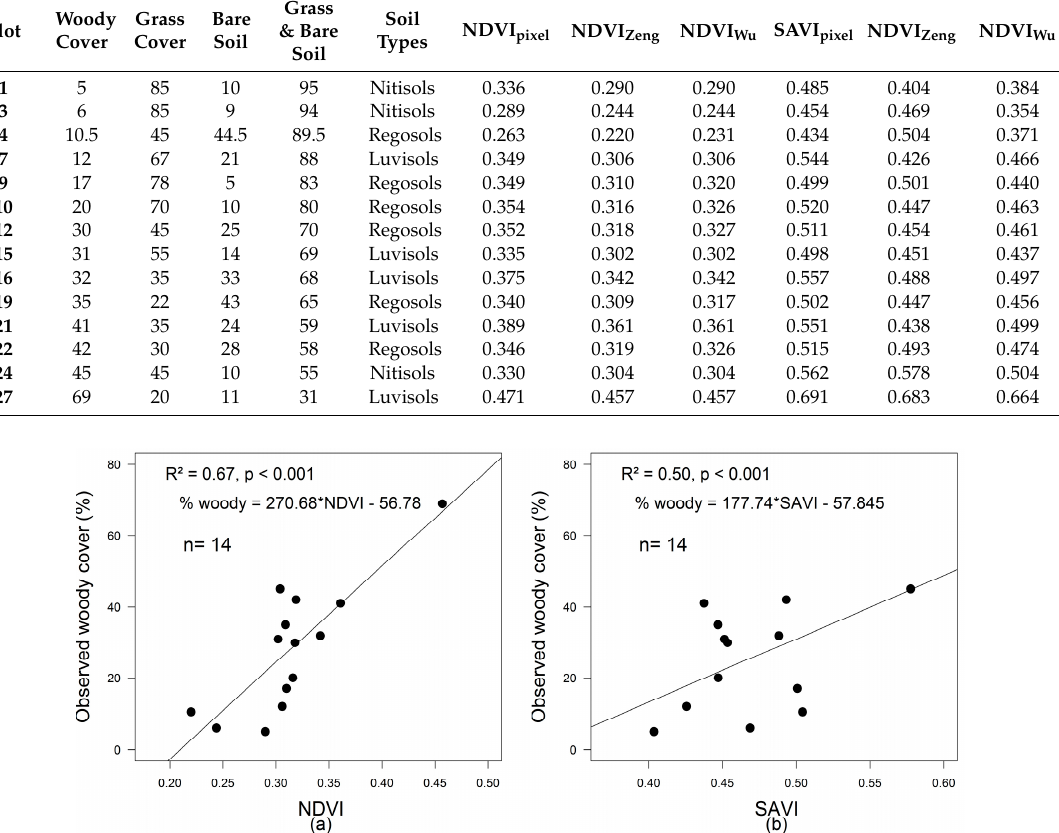
Table 2. Estimates of percent cover using NDVI and SAVI with soil determining methods using a modified procedure by Zeng et al. [34] and Wu et al. [35]